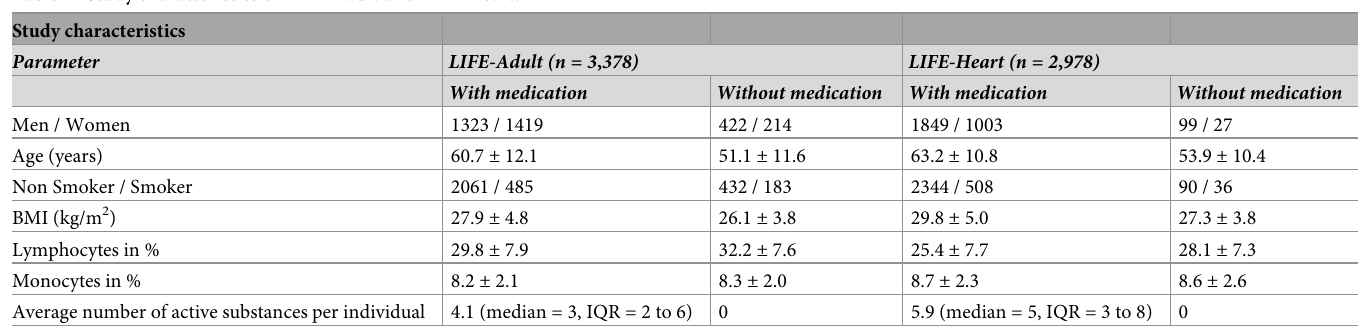
Table 1. Study characteristics of LIFE-Adult and